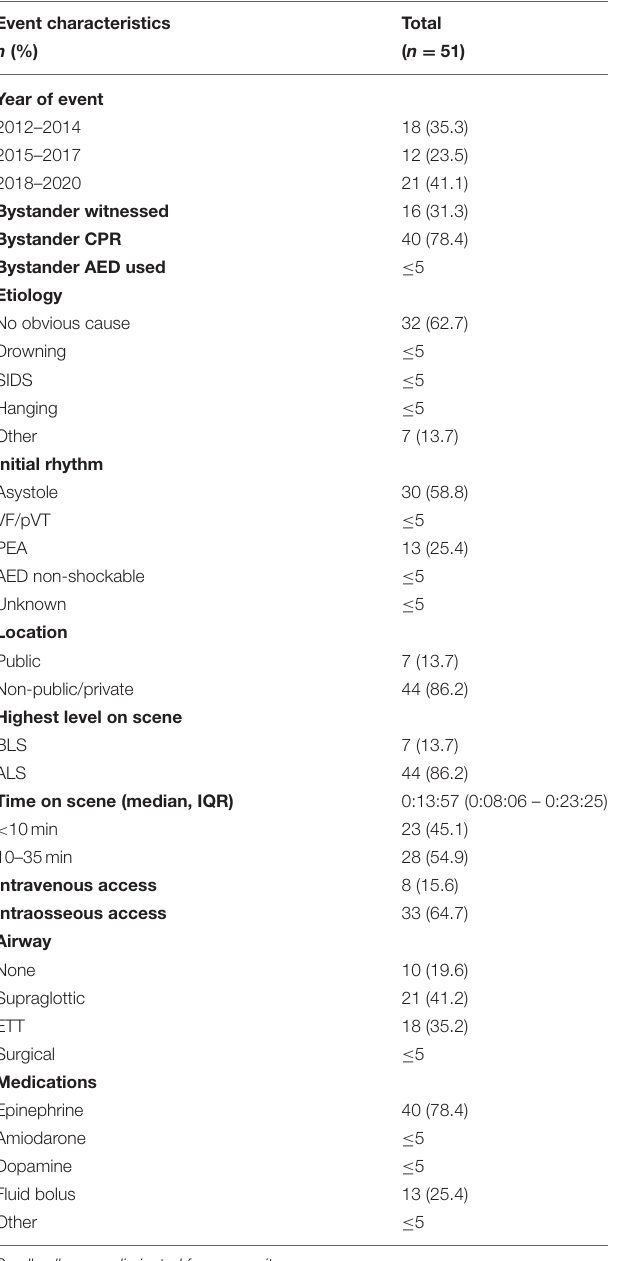
TABLE 2 | Event characteristics. TABLE 3 | Number of deviations occuring per